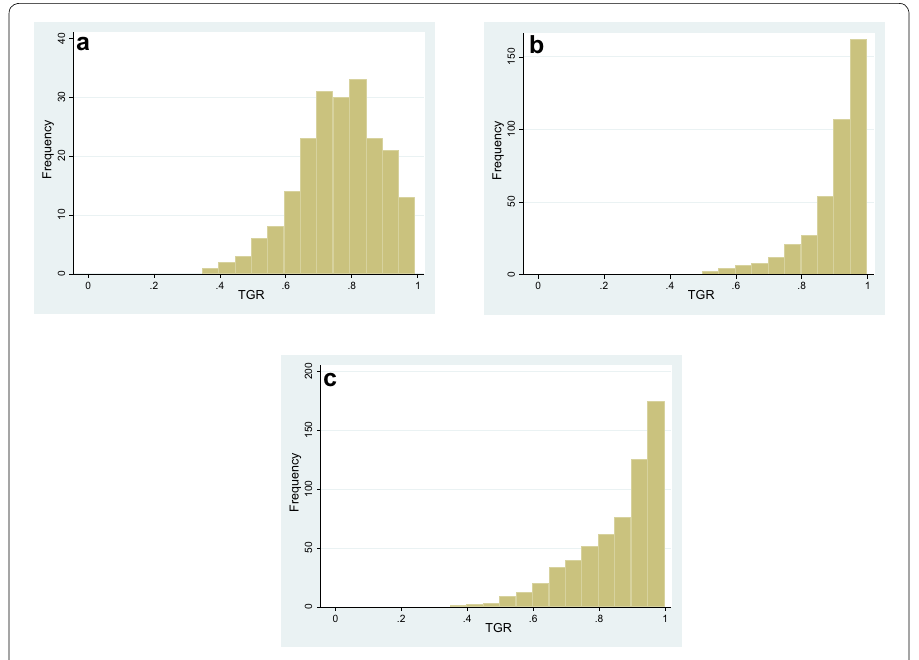
Fig. 3 Histograms of the TGRs. a Group 1 (metropolitan). b Group 2 (rural). c